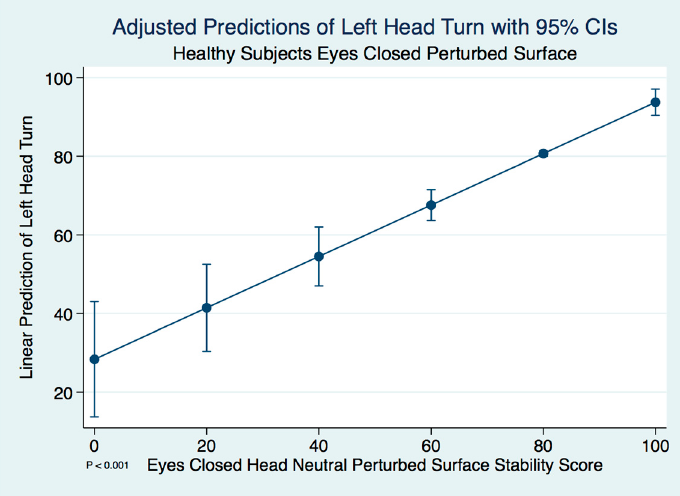
Figure 4. Adjusted predictions of left head turn stability scores in healthy normal controls.